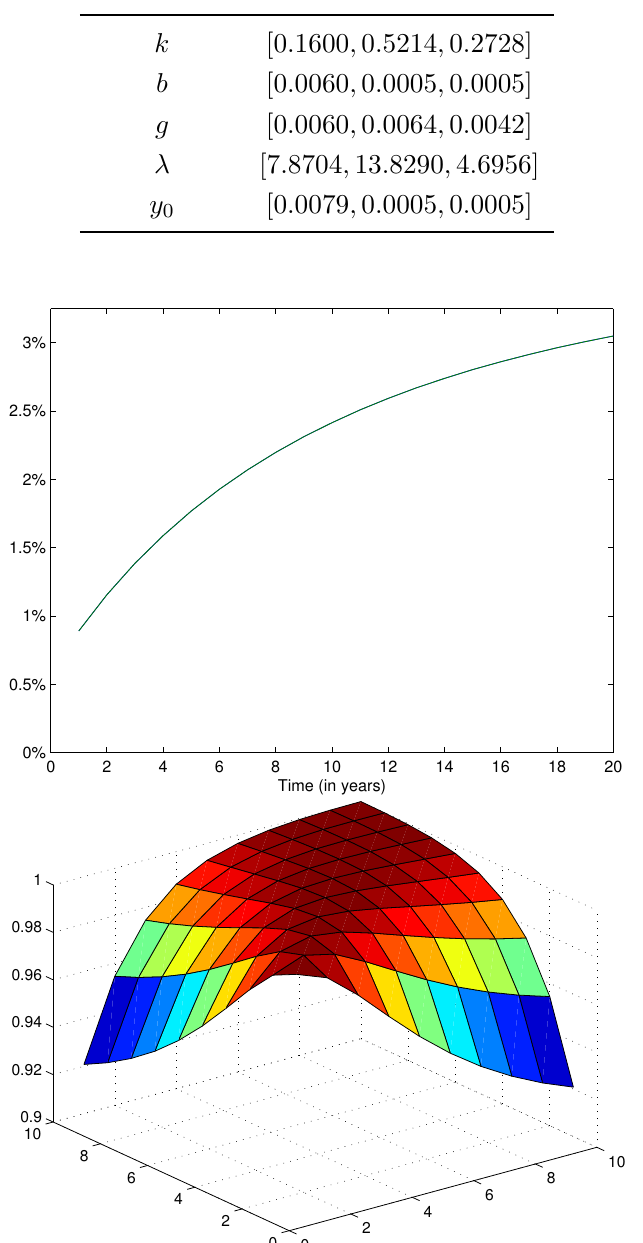
Figure 6. Correlation and yield curve for Parameter set